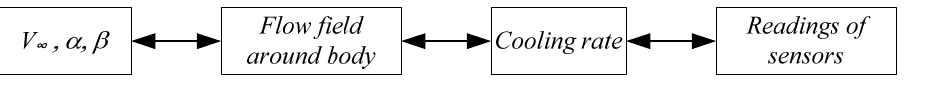
Figure 5. Relationship between the sensors’ readings and aerodynamic